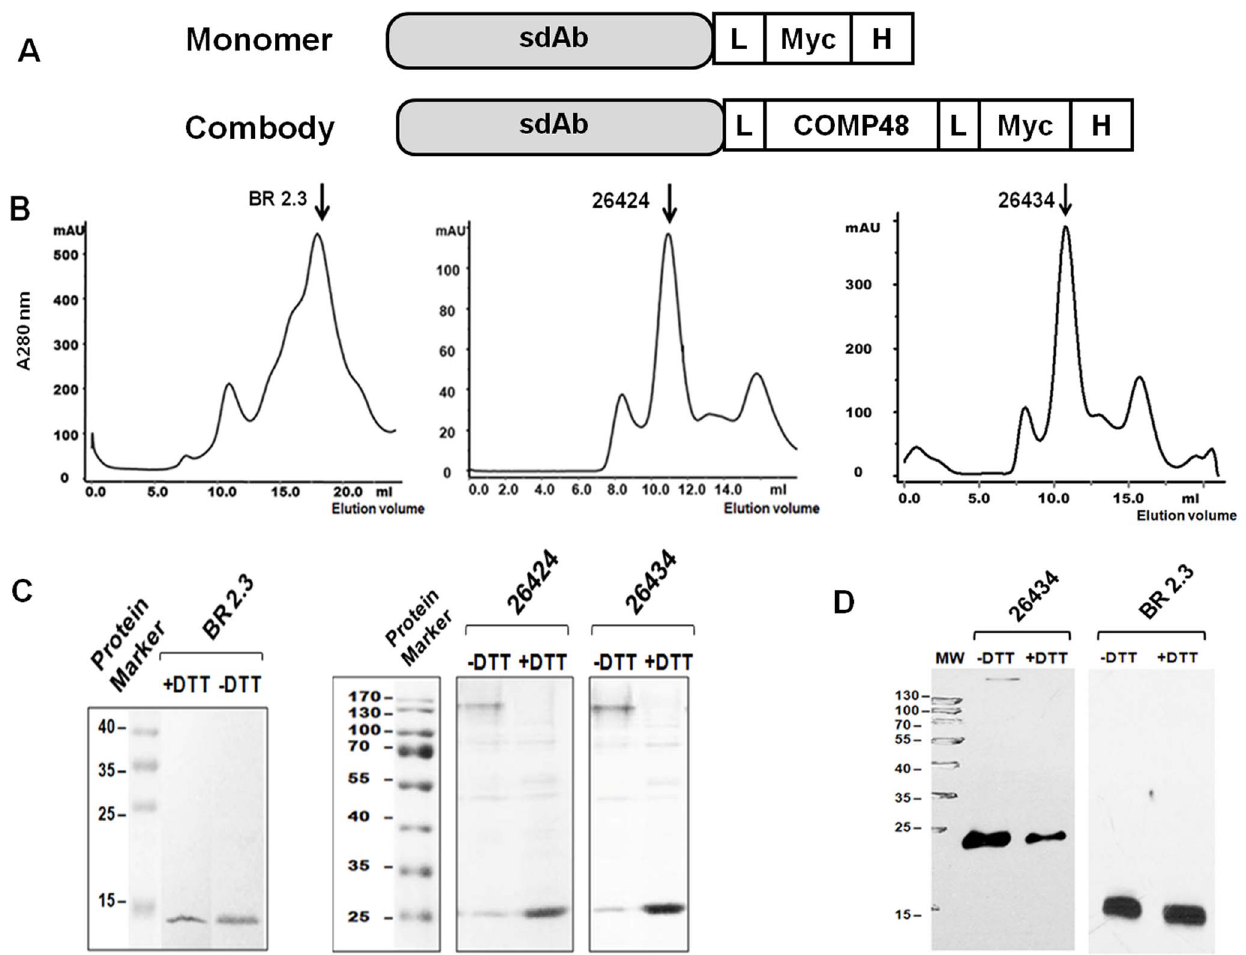
Figure 3. Characterization of sdAb monomer and combodies. (A). Primary structure of monomer and combodies of the sdAbs used in our study are shown. (B) Size-exclusion chromatography of BR 2.3, 26424 and 26434. The size of the monomeric and multimeric sdAbs was analyzed through Sephadex 200 chromatography and the elution positions have been depicted. (C) The size of BR 2.3, 26424 and 26434 has been further confirmed through SDS-PAGE. BR 2.3 elutes as a 14 kDa monomer in both reducing ( + DTT) and non-reducing (-DTT) conditions. Combodies 26424 and 26434 elutes as 25 kDa protein in reducing conditions and appears to be more than 130 kDa in non-reducing SDS-PAGE, suggesting pentamerization of the coiled-coil peptide. (D) The monomeric and pentameric sdAbs were further analyzed in Western blot. The purified proteins were run in a 12% SDS-PAGE in both reducing and non-reducing conditions. The antibodies were detected using Mouse anti- myc IgG and HRP- labeled goat anti-mouse IgG followed by chemiluminiscence detection. The figure depicts Western blot for 26434 and BR